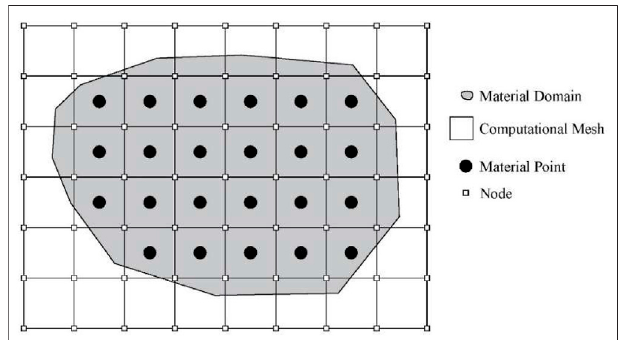
FIGURE 1 | Material discretization of the